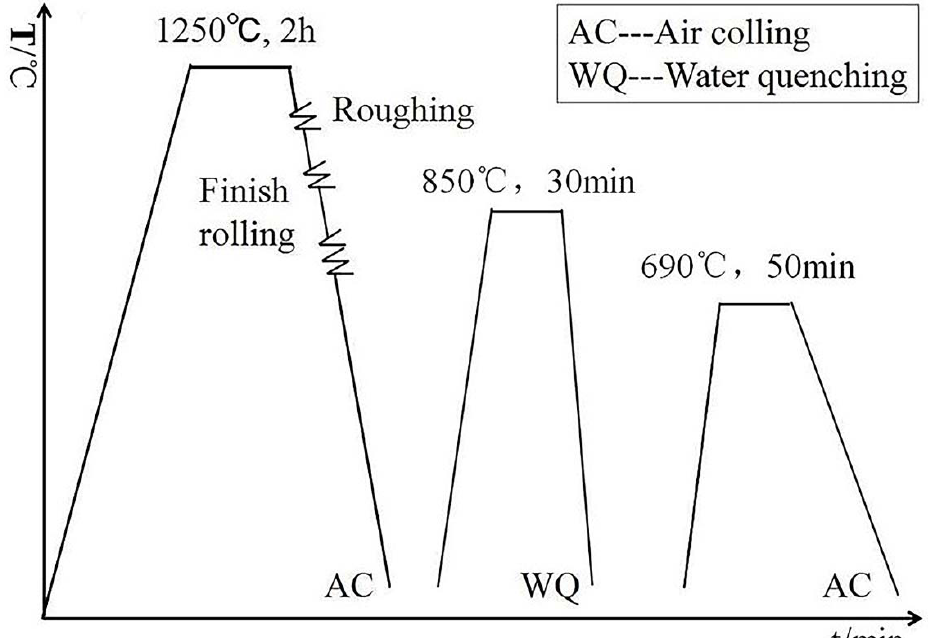
Figure 1. Hot rolling and heat treatment process of experimental steels.